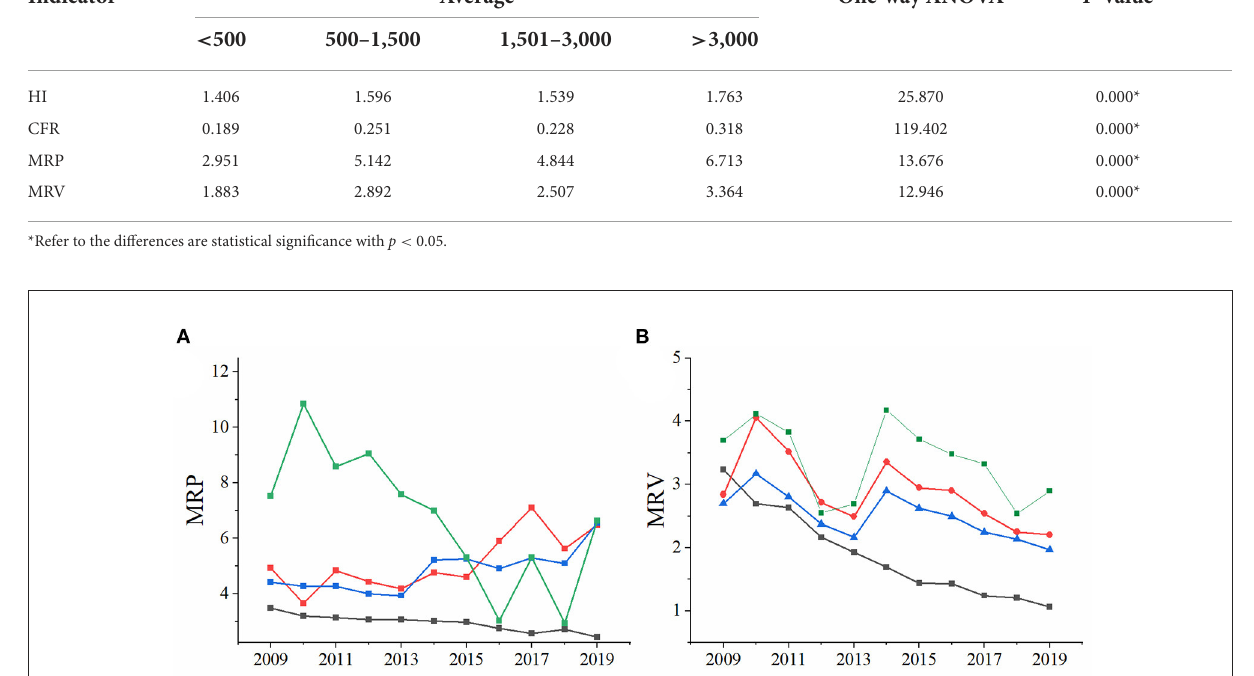
eastern regions in terms of road grade ( p = 0.000). Distribution of road grades were seen in Figure